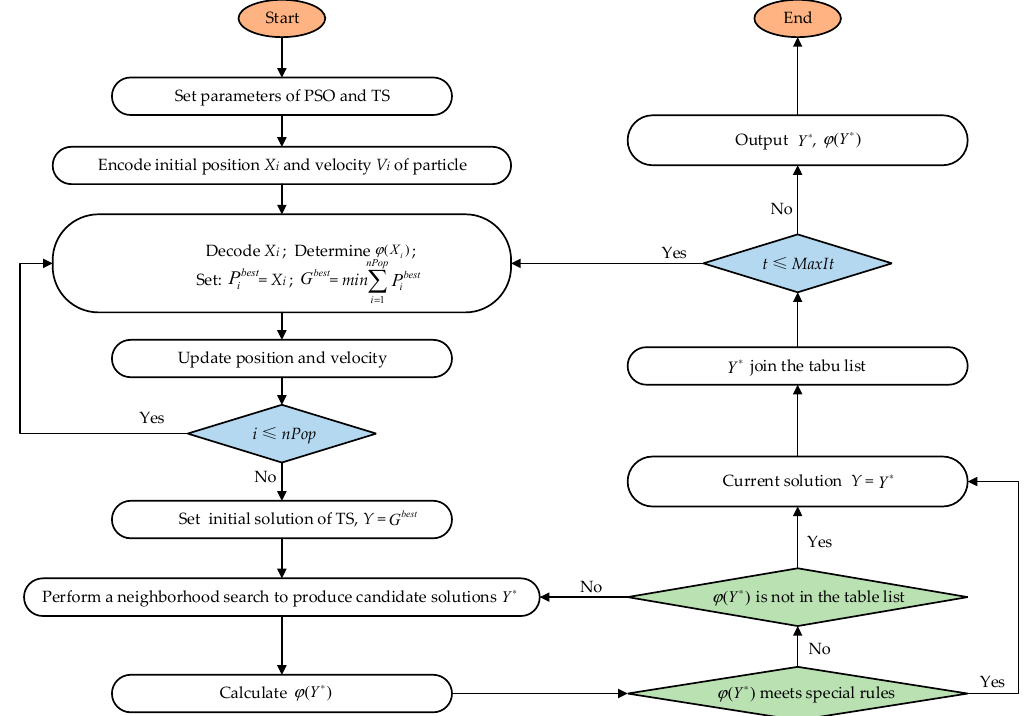
Figure 2. Basic procedures of the proposed particle swarm algorithm (PSO)-tabu search (TS) algorithm.